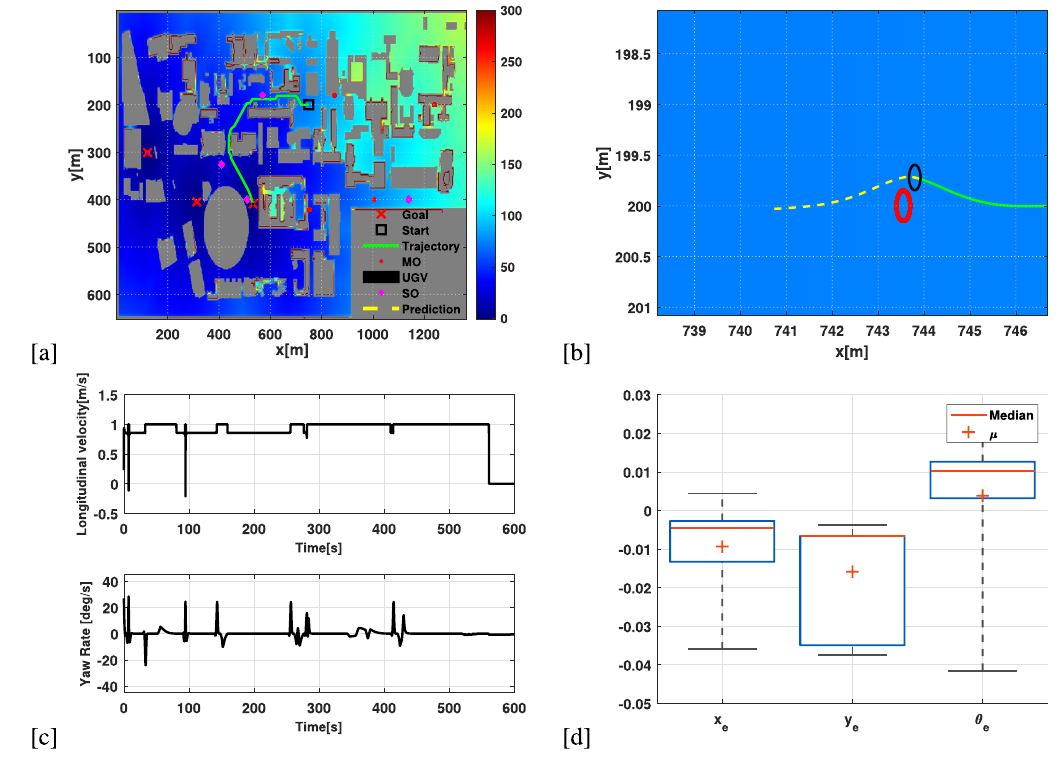
Figure 3. ( a ) Path-tracking of the UGV with a birds eye-view of the UNSW map. ( b ) Collision avoidance of incoming MO as well as the prediction of future state. ( c ) Applied longitudinal and angular velocity of the UGV. ( d ) Tracking error representation of the vehicle’s actual